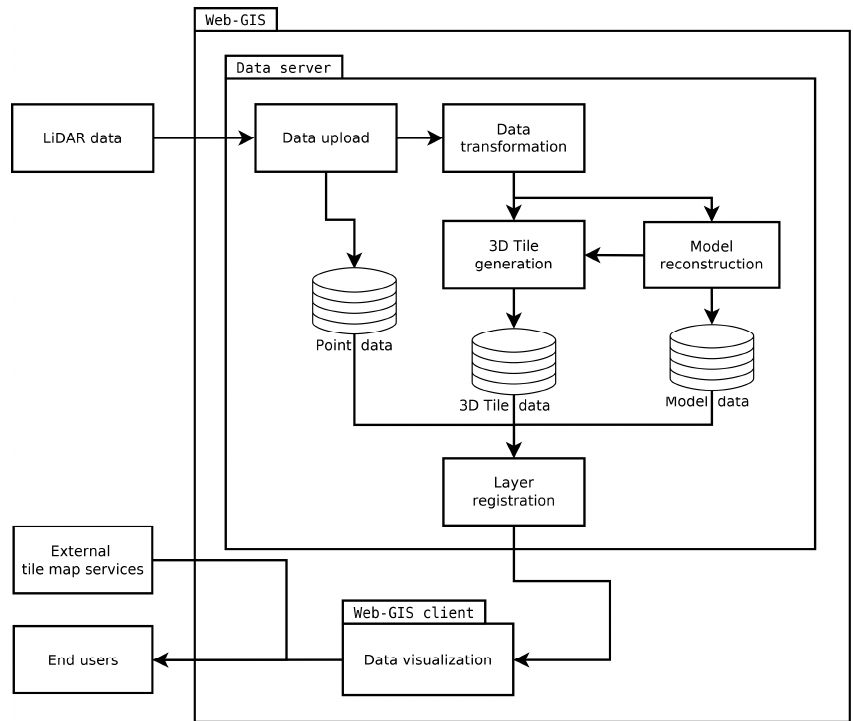
Figure 1. Architecture of the system for online processing, storage, visualization and dissemination of Light Detection and Ranging (LiDAR) survey results.